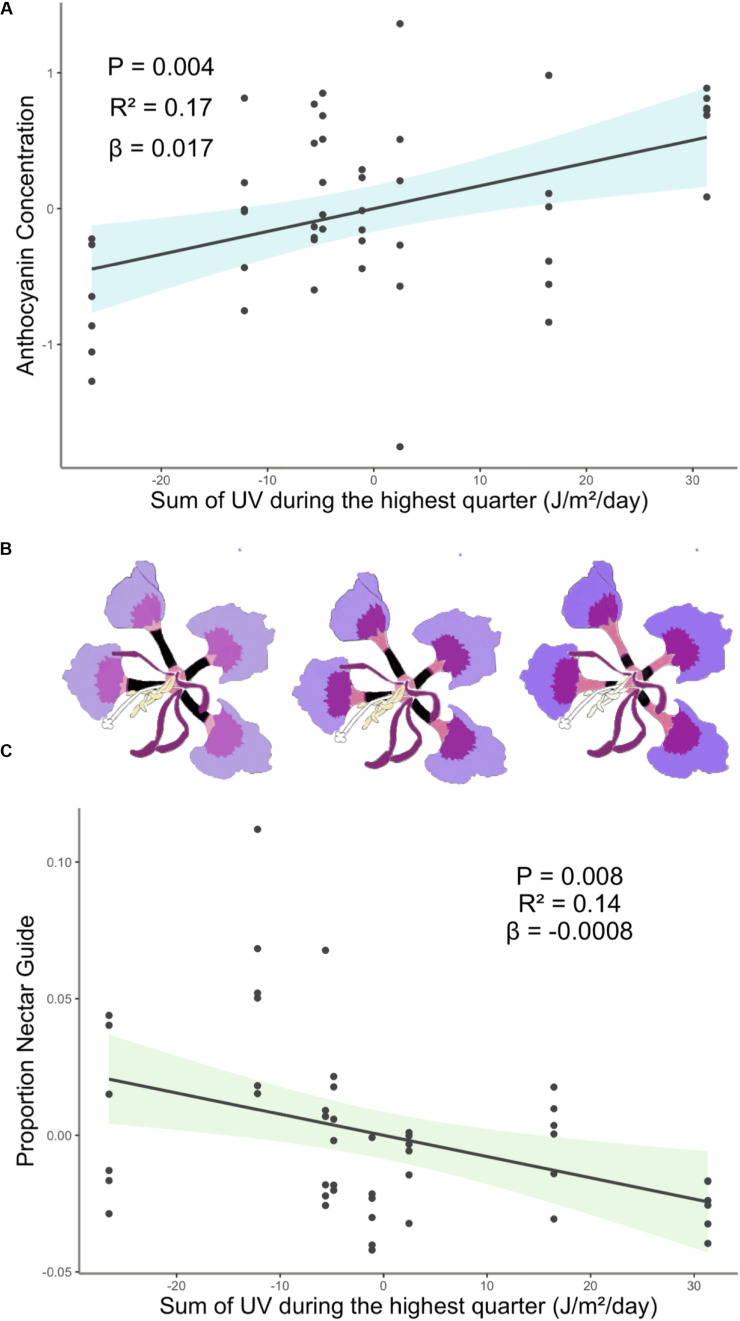
(A) Anthocyanin concentration was highest in populations with high SumUV (B) Representative depiction of geographic variation in estimated mean floral anthocyanin concentration and proportion nectar guide of eight populations of C. unguiculata. UV-absorbing nectar guides begin at the base of the claw and extend up each claw toward the blade. In this figure they are depicted as black rectangles, which is similar to how they appear in UV photos. (C) Proportion nectar guide was largest in low SumUV populations. Shaded area indicates the 95% confidence interval. β = the regression coefficient associated with the independent variable in each panel. P = the P-value associated with the regression coefficient. R2 = the partial r squared associated with the independent variable in each panel.